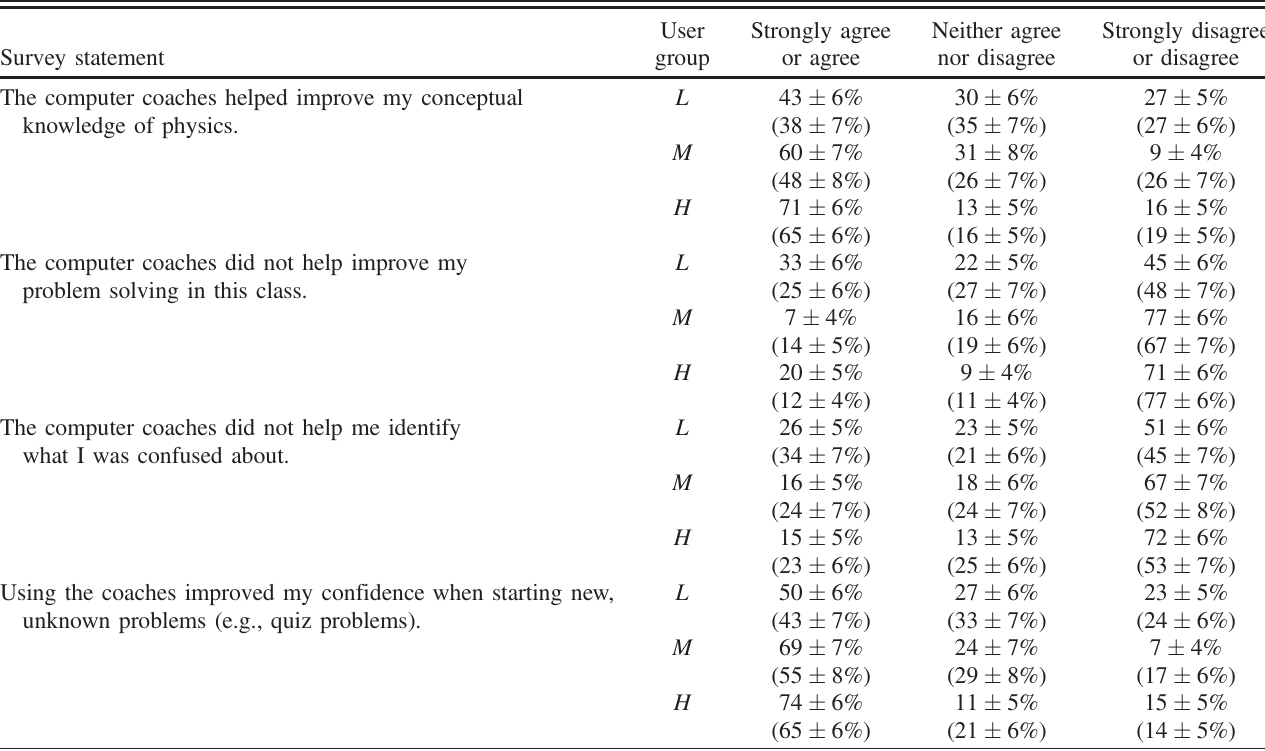
TABLE VIII. Spring 2013 student responses to questions from an end-of-semester survey about the usefulness of the computer coaches. Numbers in parentheses are student responses from a midsemester survey. Survey